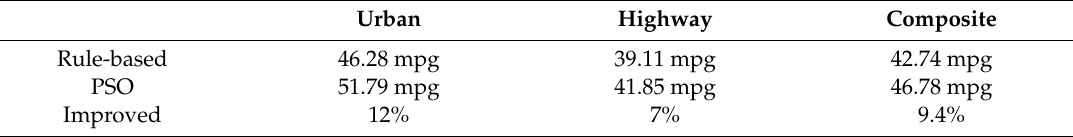
Table 3. Comparison of fuel economy.